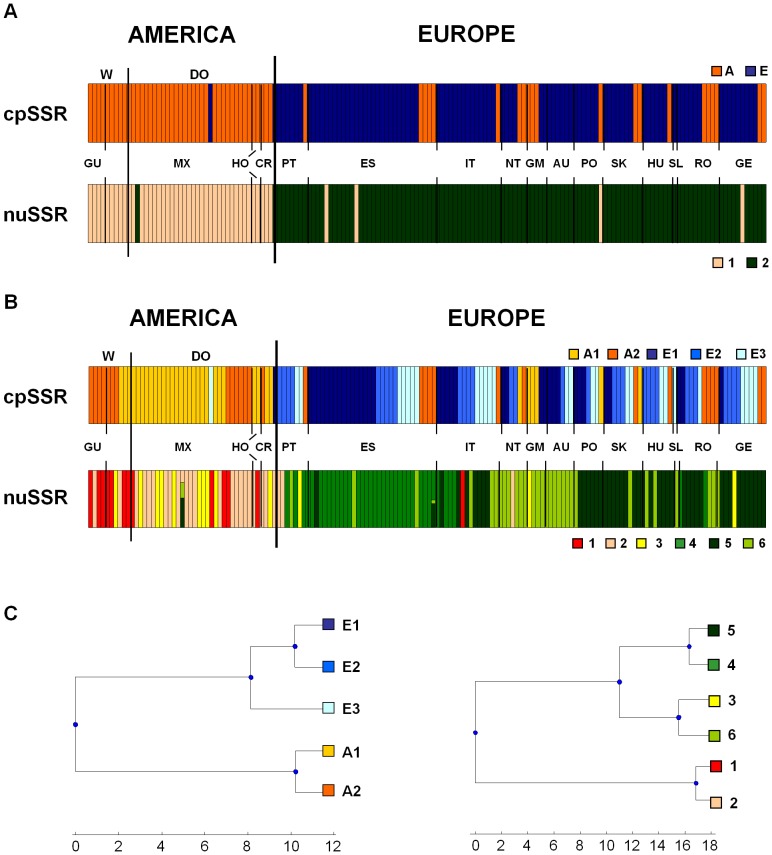
Cytoplasmic and nuclear genetic structure.Comparison between the different clusterings of the accessions as inferred by BAPS at K2 (A) and at K5 and K6 (B) for cpSSR and nuSSR data. Only accessions shared between Spataro et al. [20] and the present study (158) are included; (C) TFPGA tree based on cpSSR and nuSSR Kullback–Leibler divergence matrices, as obtained with BAPS analysis.